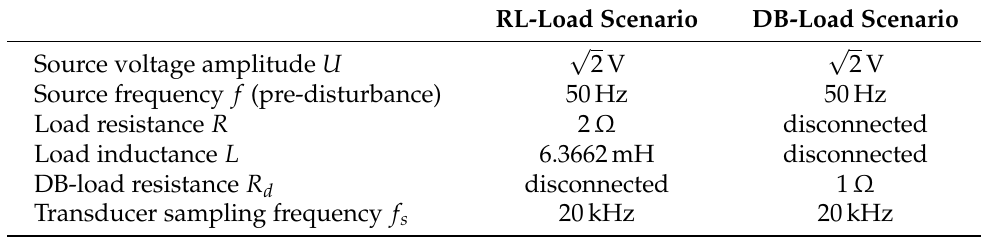
Table 1. Computer simulation data for the RL-load and DB-load scenarios.